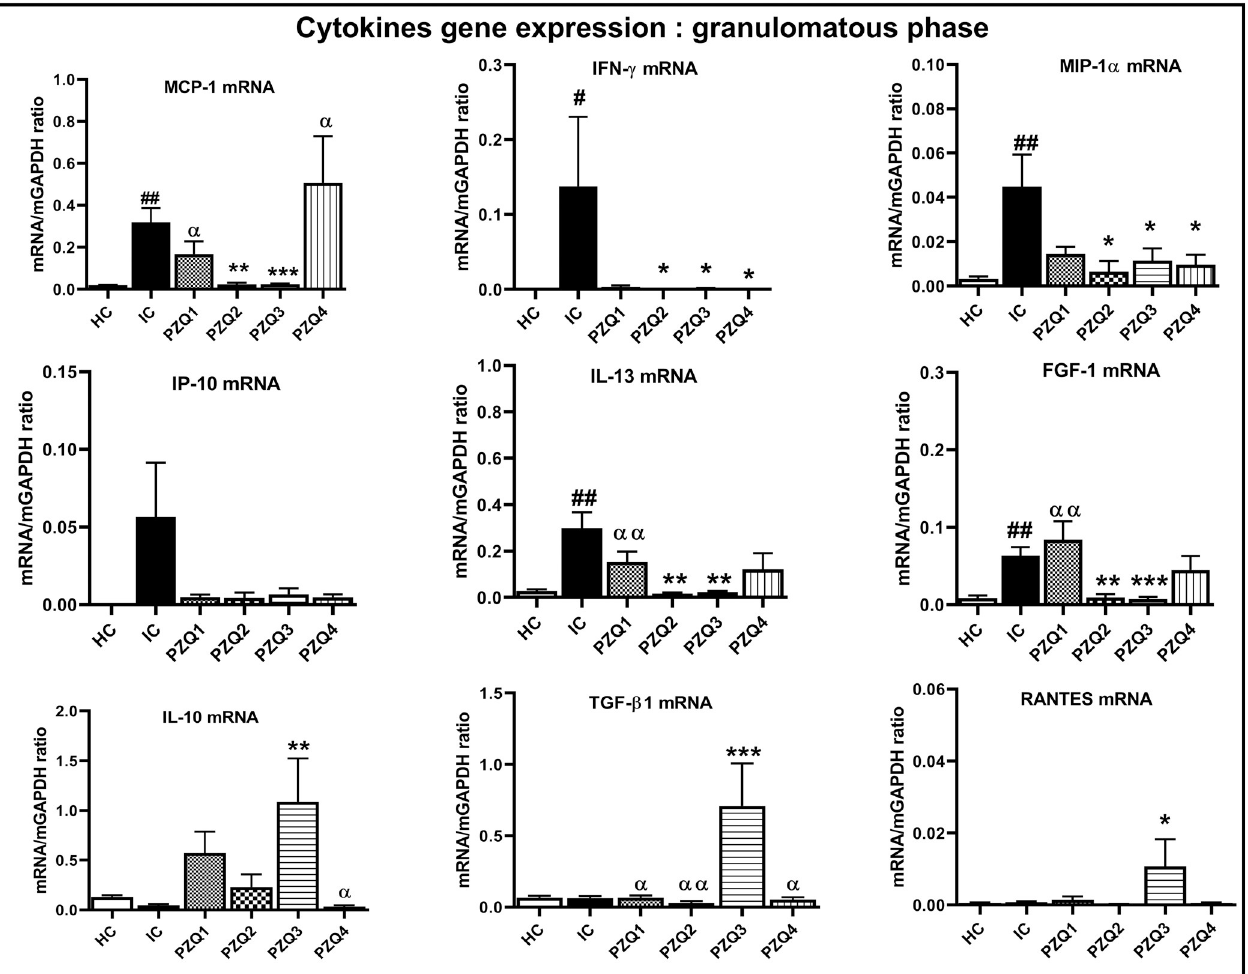
Fig 13. Effect of praziquantel treatment on the liver mRNA expression of cytokines and chemokines during the granulomatous stage of Schistosoma mansoni infection in mice. HC: Uninfected mice, IC: Infected-untreated mice, PZQ1: Infected mice treated with praziquantel at 100 mg/kg for 5 consecutive days, PZQ2: Infected mice treated with praziquantel at 100 mg/kg for 28 consecutive days, PZQ3: Infected mice treated with praziquantel at 18 mg/kg for 28 consecutive days, PZQ4: Infected mice treated with a single dose of praziquantel at 500 mg/kg. Data are expressed as mean ± SEM (n = 6). ANOVA followed by Tukey multiple comparison test was also used for statistical analysis. # p < 0.05, ## p < 0.01: values are significantly different from those uninfected mice (group HC). � p < 0.05, �� p < 0.001, ��� p < 0.001: values are significantly different from those of infected-untreated mice (group IC). α p < 0.05, αα p < 0.01: values are significantly different from those of infected mice treated with PZQ3 posology (group